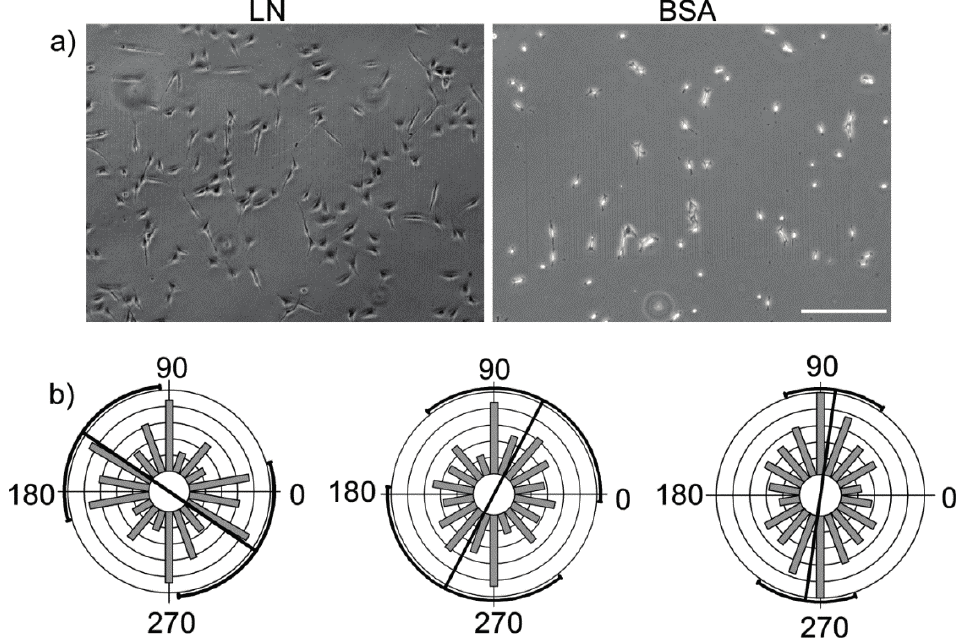
Figure 7. ( a ) Representative phase contrast images of OVCA433 cells on LN ( left ) and BSA ( right ) gradients 12 h after seeding. The cells are better spread on the LN gradient. Scale bar = 200 microns. ( b ) Polar plots of the orientation of the OVCA433 cells on the low, medium, and high slope ranges of the BSA gradient, showing a random distribution in each case. Polar plots are used for better visualization of the random